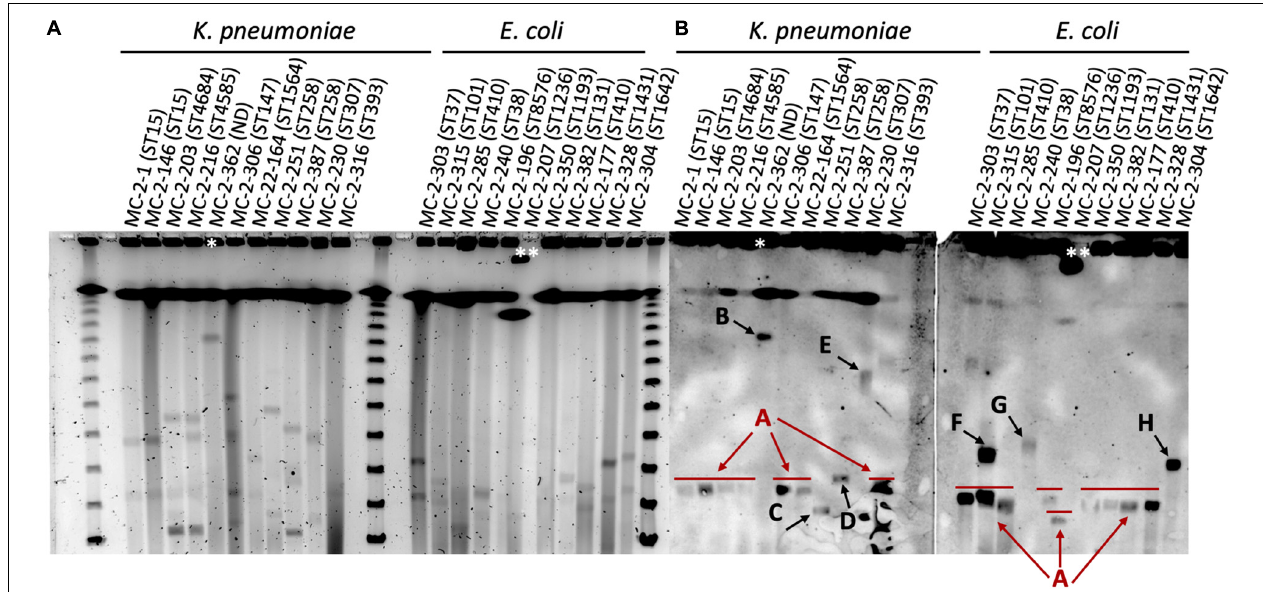
FIGURE 2 | (A) S1-nuclease-PFGE profiles and (B) corresponding southern hybridization membranes with bla KPC probes of selected K. pneumoniae and E. coli isolates in this study. The ST of both K. pneumoniae and E. coli isolates is shown in brackets. Arrows indicate the different arbitrarily designated plasmid types. Lambda ladder PFGE Marker (New England Biolabs, United States). * Enterobacter sp. isolate. **The PFGE plug moved from the loading site, so the band is shifted. ND, not